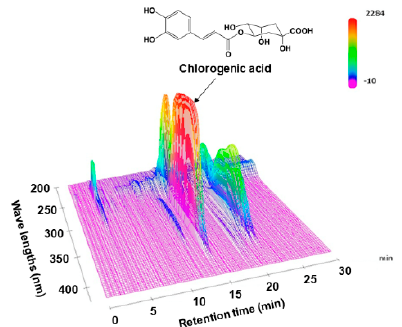
Figure 1. Three-dimensional high-performance liquid chromatogram of Lonicera japonica flower bud extract